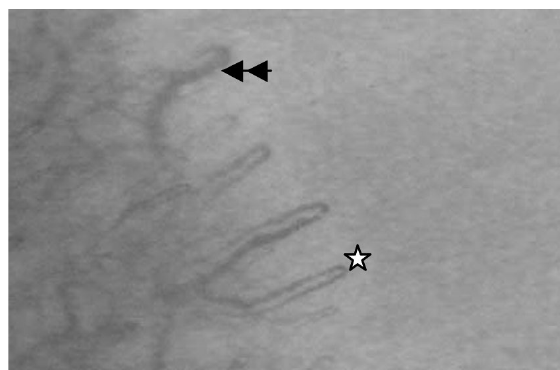
Fig.3. Capillary morphological anomalies with subpapillary venous plexus and homogen- eously dilated efferent limb (arrow). Normal (typical) capillary loop looks hairpin